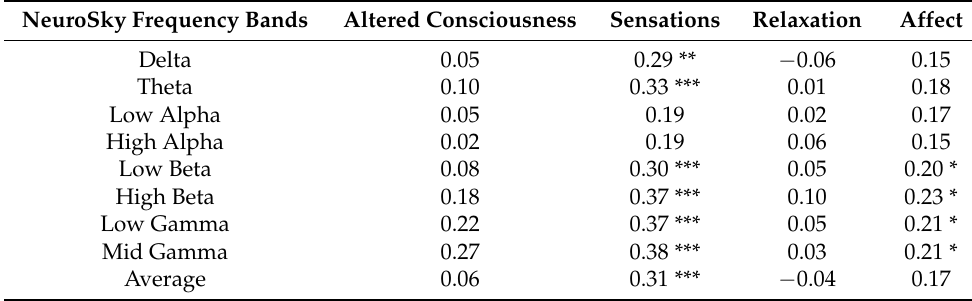
Table 8. Correlations between ASMR-15 and NeuroSky frequency bands. NeuroSky Frequency Bands Altered Consciousness Sensations Relaxation Affect Delta 0.05 0.29 ** − 0.06 0.15 Theta